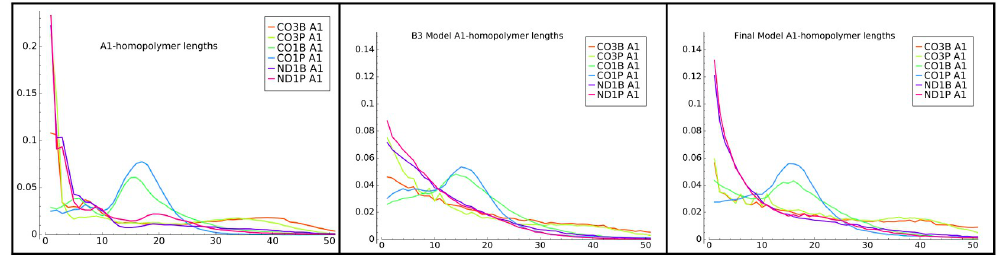
Fig 11. Model B3 A1-homopolymers. Distribution of initial (A1) homopolymer lengths generated by model